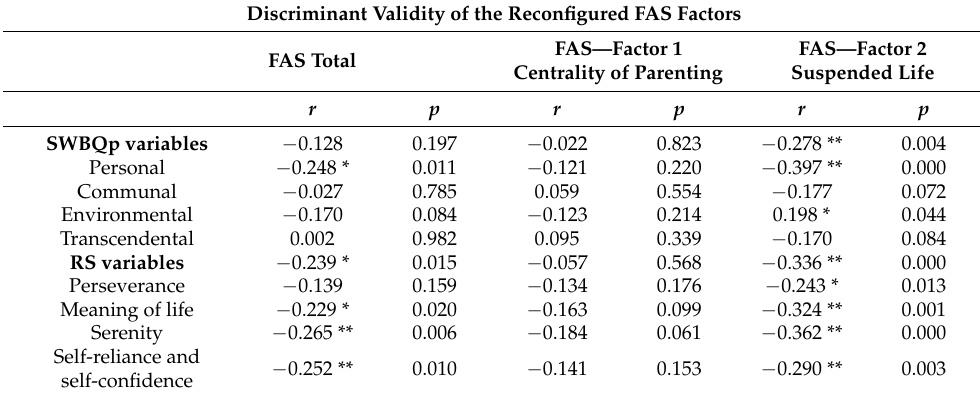
Table 8. Discriminant validity of the reconfigured Resilience Scale factors. Discriminant Validity of the Reconfigured FAS Factors FAS—Factor 1 FAS—Factor 2 FAS Total Centrality of Parenting Suspended